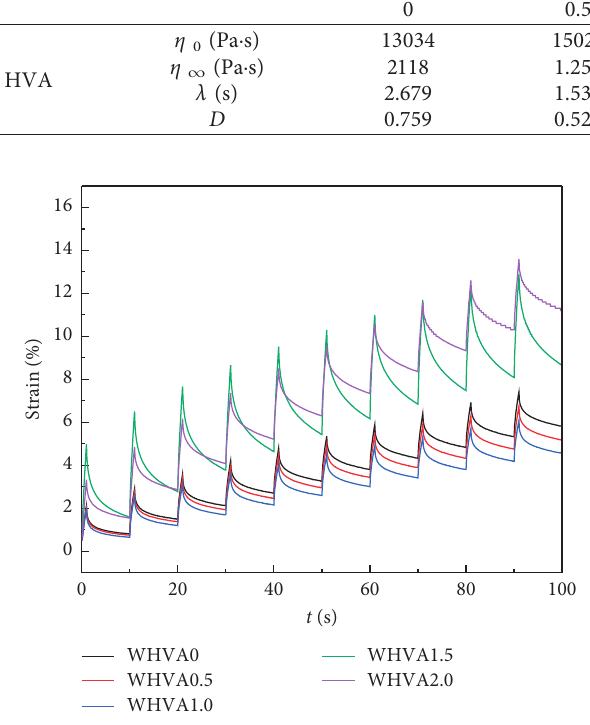
Figure 7: Strain response in the MSCR test (ten cycles) for warm- mix HVA at 60 ° C and